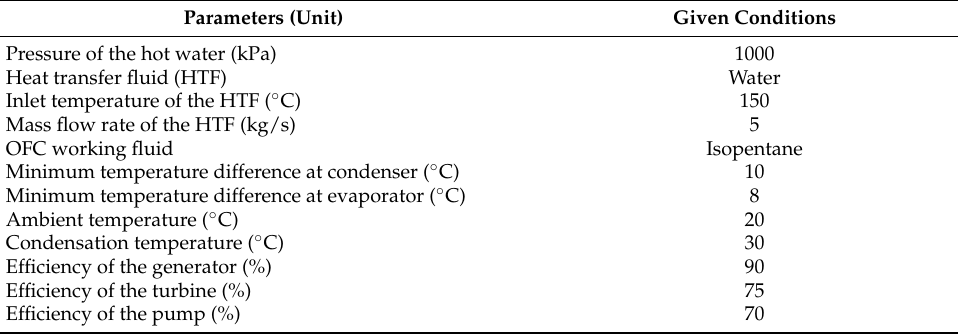
Figure 2. Parametric optimization for the ROFC. Table 3. Basic given conditions used for optimization [19].